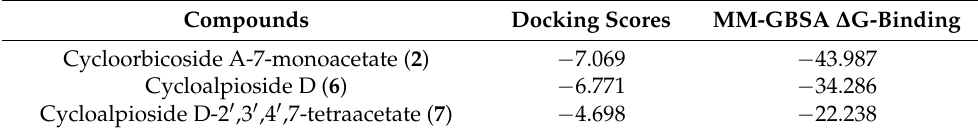
Table 3. Docking scores and MM-GBSA values of the selected triterpenoid ligands expressed in